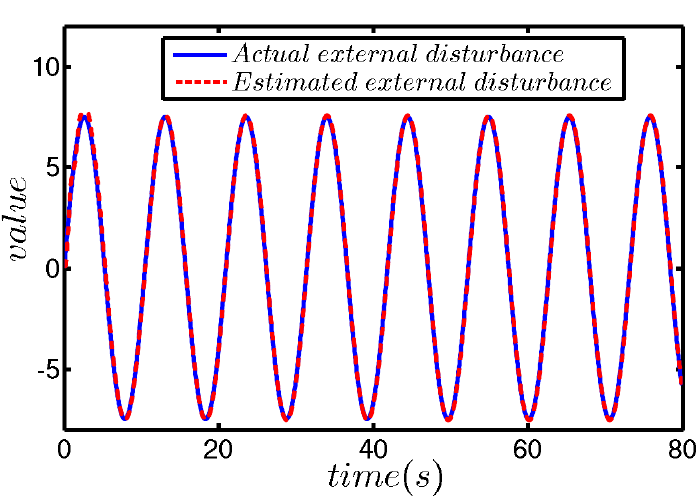
Figure 9. The curves of disturbance estimation under strong